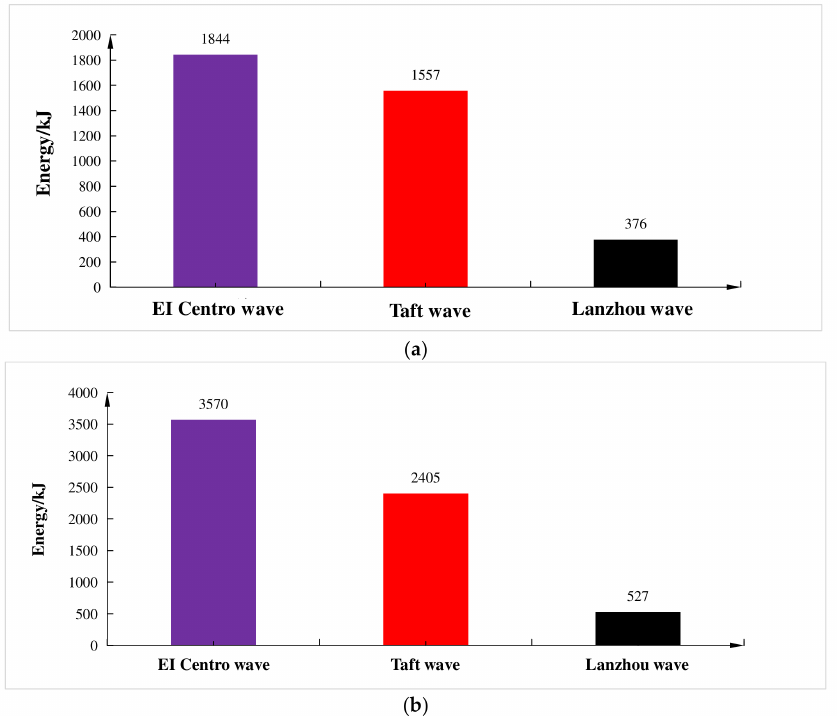
Figure 14. Hysteretic energy dissipation capacity curves of structure. ( a ) Input peak acceleration is 100 gal; ( b ) Input peak acceleration is 200